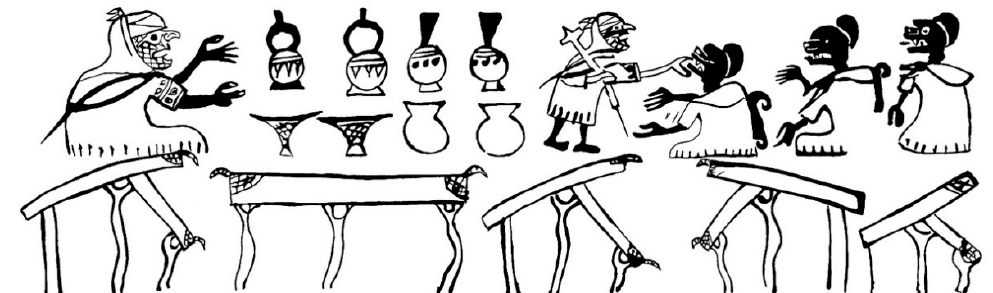
Figure 9. Women Gesturing towards Anthropomorphic Bats. Dumbarton Oaks Research Library and Collection, The Moche Archives, Drawn by Donna McClelland (Image ID